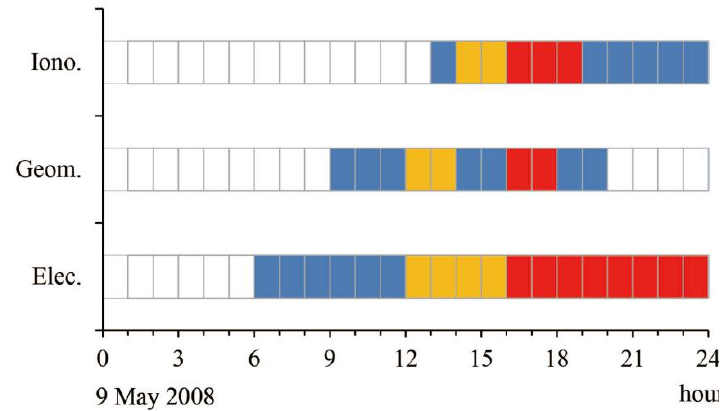
Figure 8. Fluctuating processes on ULF electrical (Elec.) emissions recorded at the GBD station, DC-ULF geomagnetic (Geom.) Z “double low-point” phenomenon recorded at the CD station, and previously reported ionospheric (Iono.) variations on 9 May 2008. Blue represents general variations, orange represents increasing anomalies, and red represents climax anomalies, respectively.